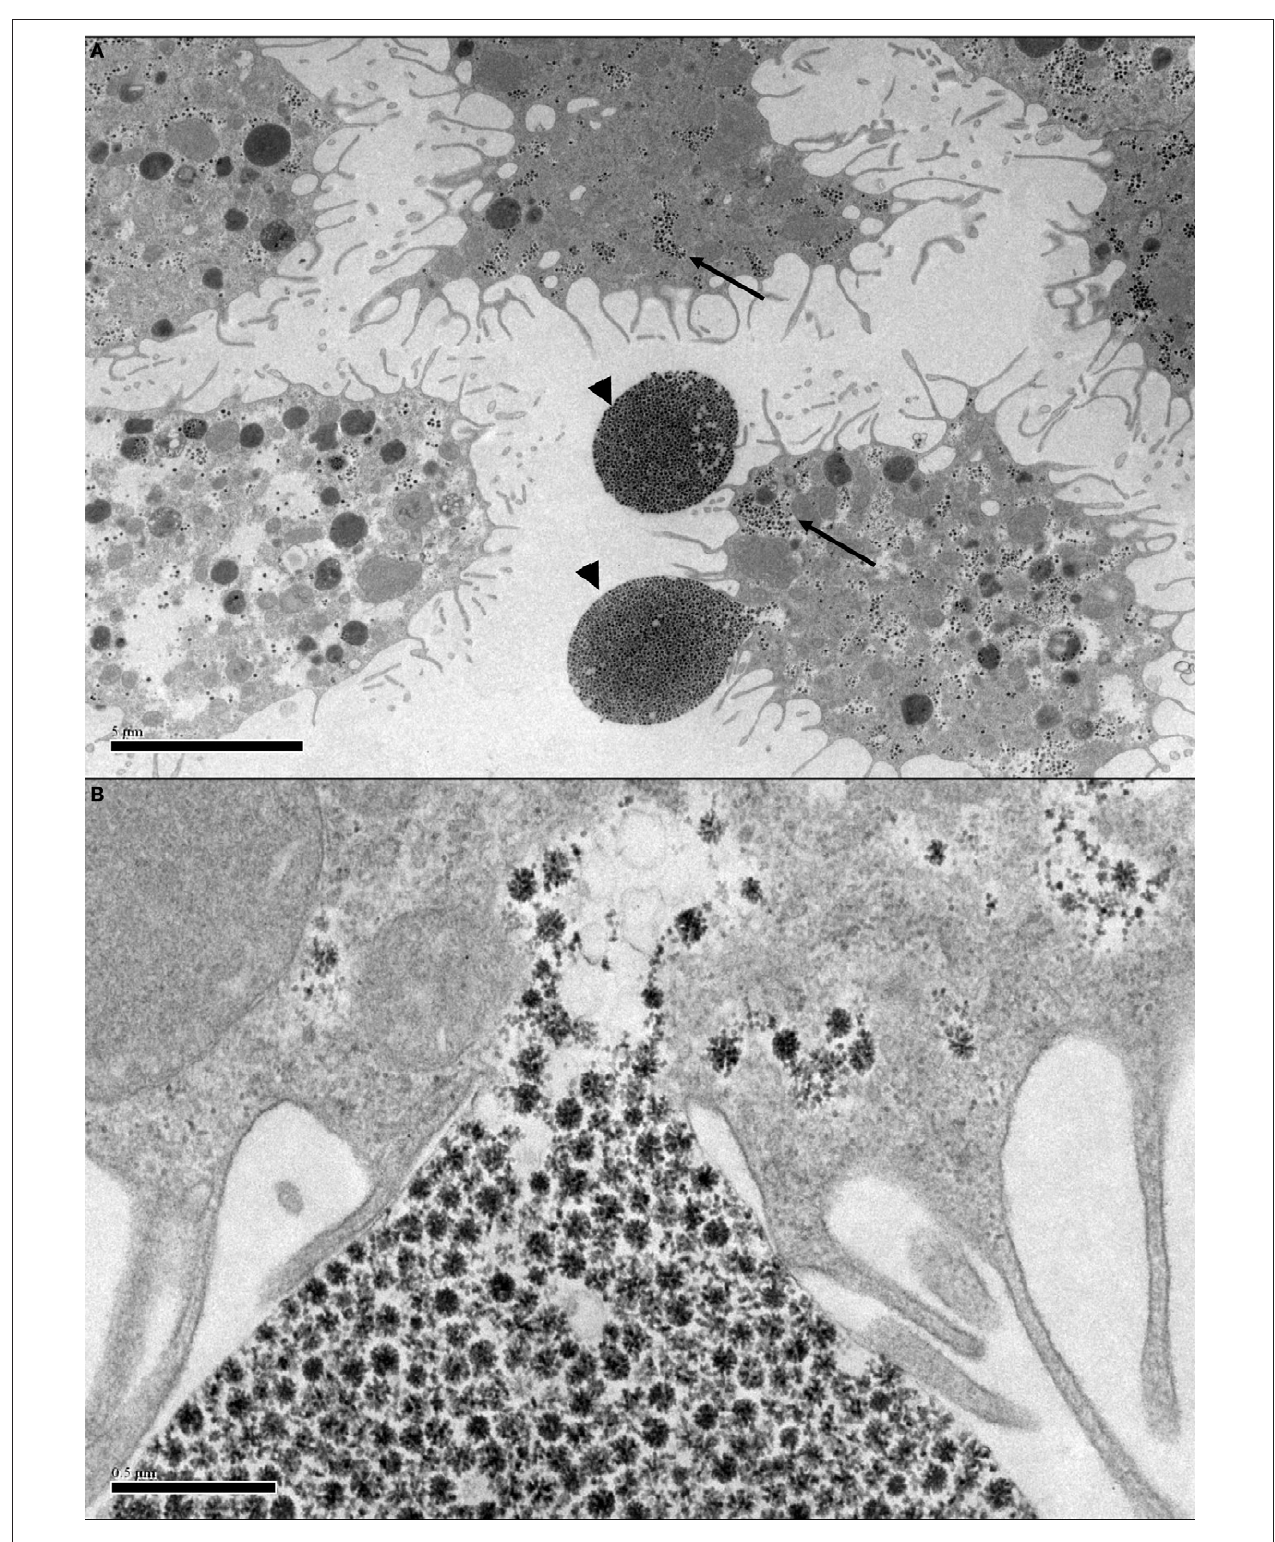
FIGURE 2 | Transmission electron micrographs of Ornithodoros moubata cell line OME/CTVM25 showing putative endogenous viruses. (A) Cells with “filopodia” extending from the cell surface. Reovirus-like particles (arrows) are abundant in the cytoplasm. The viruses appear to be using the